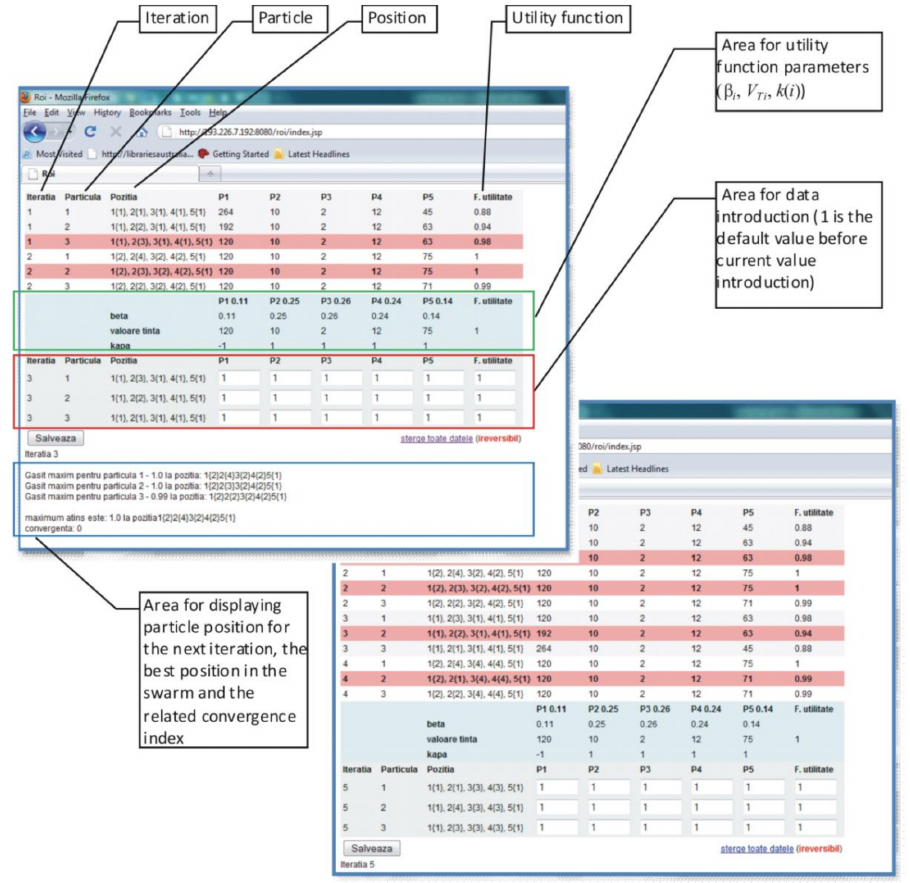
Figure 12. Screenshots showing SCV implementation in a software